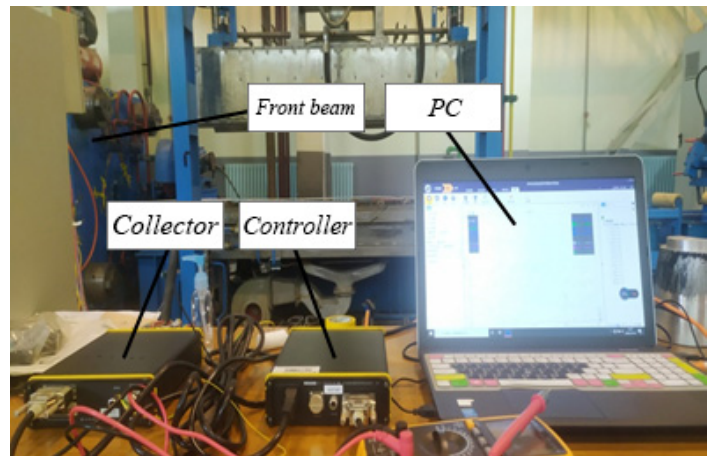
Figure 6. Stress–strain test system.